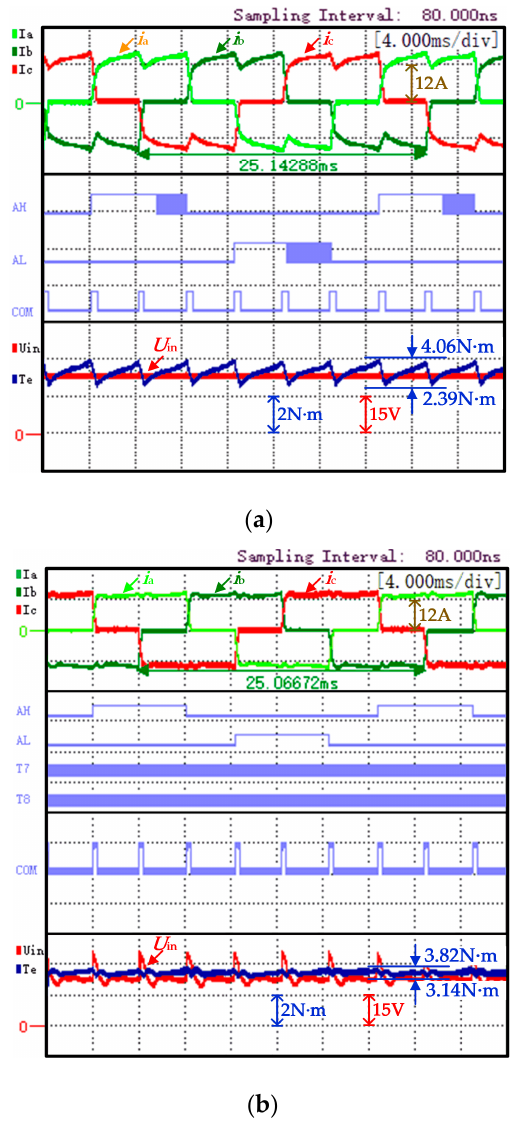
Figure 10. The experimental results with rated condition: ( a ) traditional strategy; and ( b ) proposed